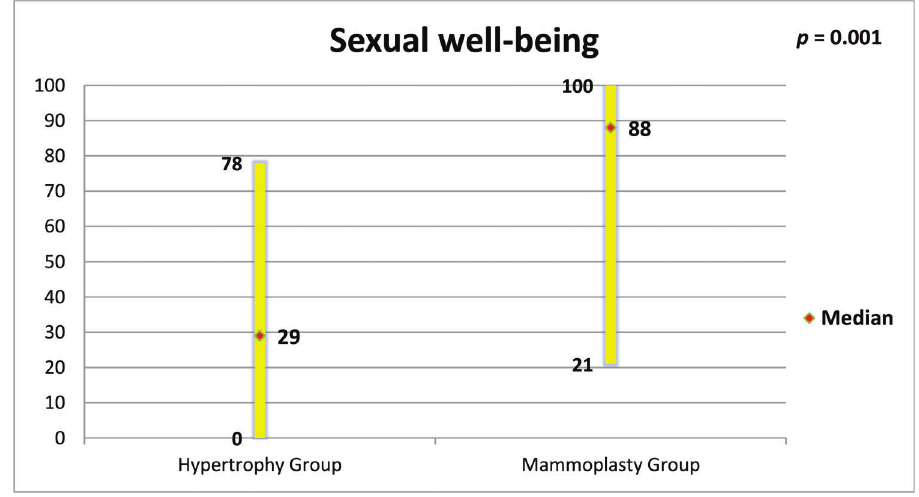
Figure 7 - Scores of BREAST-Q s subscale ‘‘ Sexual well-being ’’ in both groups and comparison by the Mann-Whitney test.